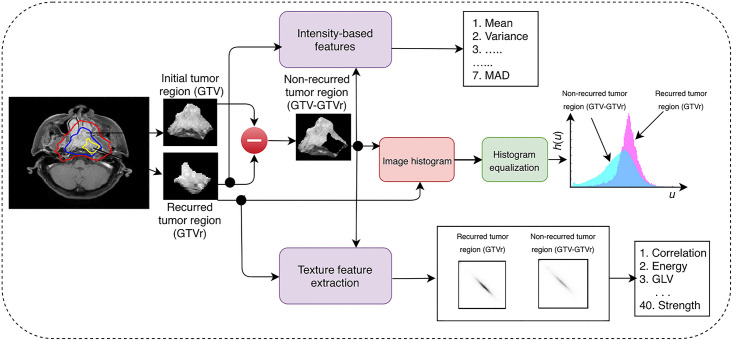
Radiomics workflow.